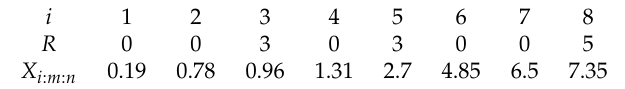
Figure 4. The estimated CDF, fitted PDF, PP-plot and QQ-plot of the EOWE distribution for complete bladder cancer data. Table 5. Censored electric data generated under progressive type-II censoring scheme.